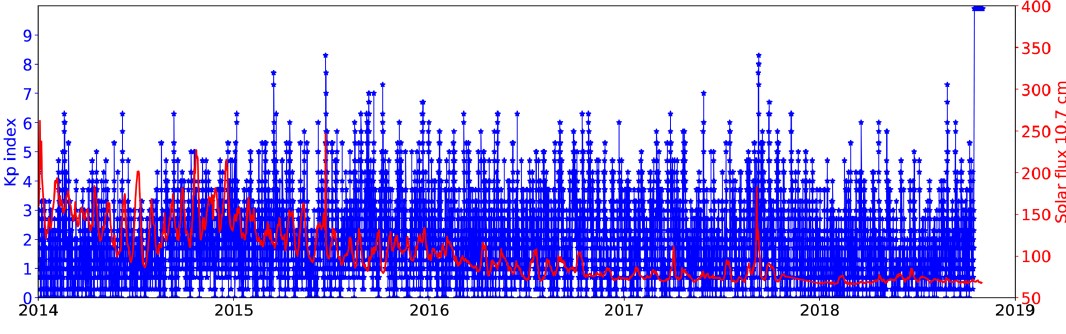
Figure 10. The 10.7cm solar radio flux in solar flux units and the Kp index during